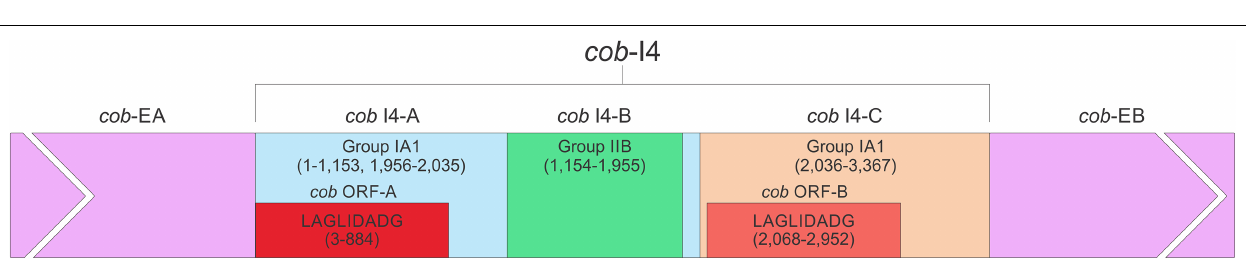
FIGURE 8 | Predicted cox3 I2 ( cox3 –640) RNA secondary structure model composed of two intron modules. Pairing regions (P1–P11) are labeled by blue text; tertiary interactions are shown by blue lines. Exon and intron sequences are represented by lowercase and uppercase letters, respectively. Red arrows indicate intron-exon/pseudoexon boundaries. (A) cox3 I2-A RNA secondary structure model. (B) cox3 I2-B RNA secondary structure model.